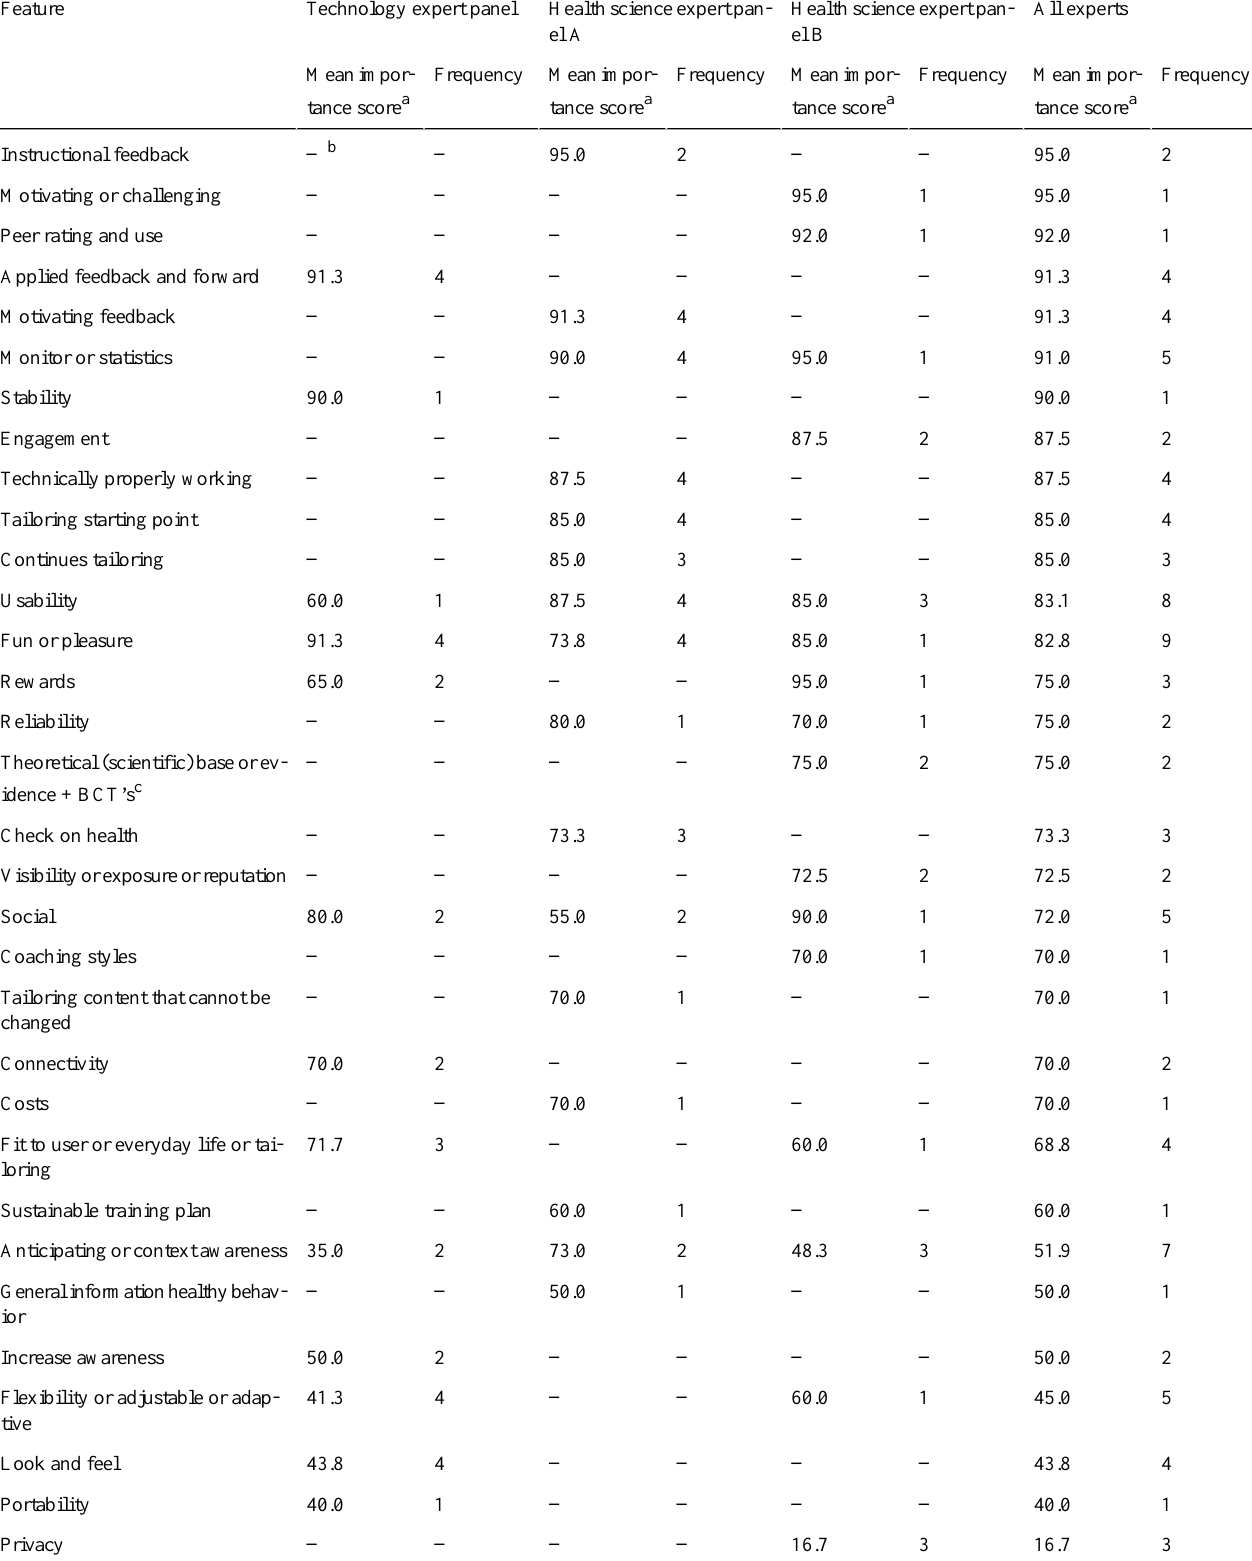
All expertsHealth science expert